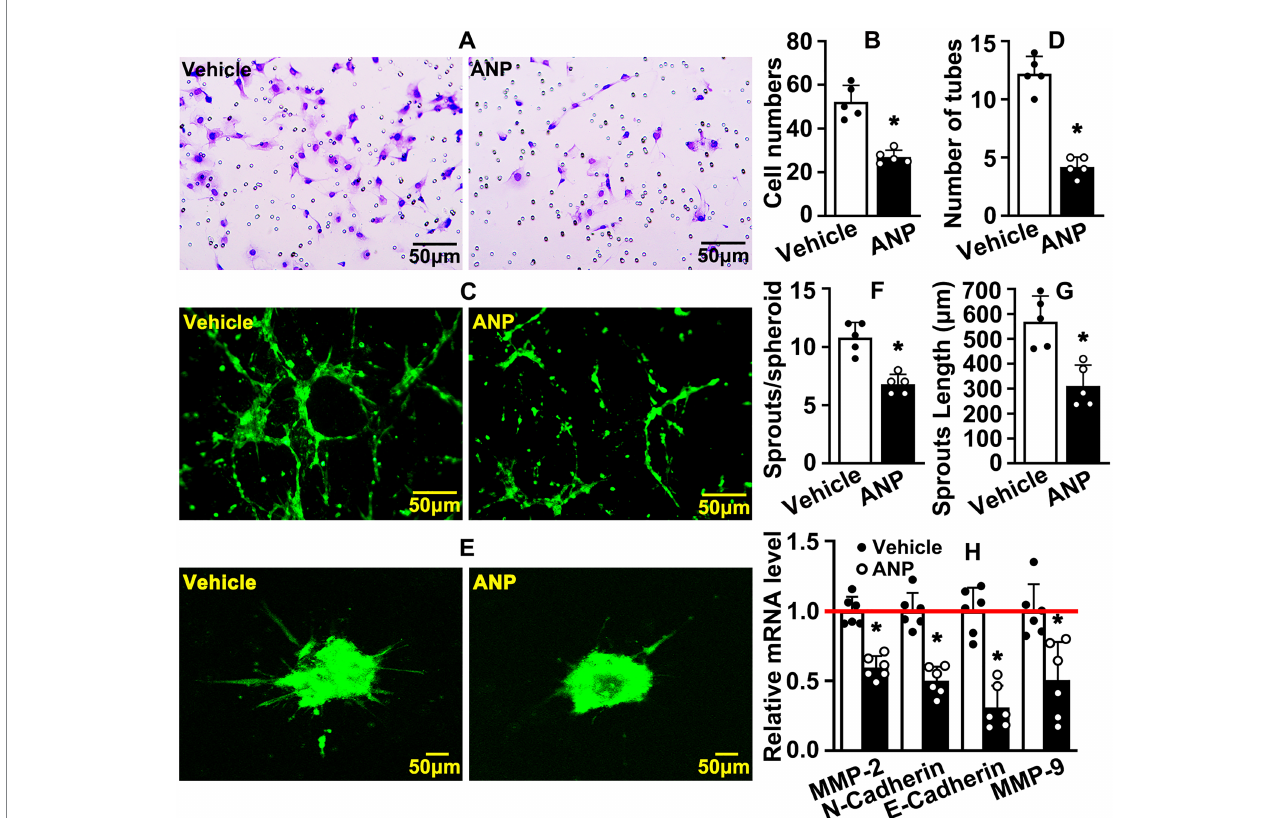
FIGURE 3 Andrographolide suppresses endothelial cell migration. (A) After 12 h of andrographolide treatment, migration of HUVEC-C was detected by Boyden chamber assay ( n = 5), and migrated cells were quantified in (B) ( n = 5). (C) Matrigel-based tube formation assay was performed following andrographolide treatment for 48 h ( n = 5). The tube numbers were quantified in (D) ( n = 5). (E) The migrating ability of HUVEC-C after andrographolide treatment for 24 h was evaluated by spheroidal sprouting assay following Calcein AM staining, and sprouting numbers and sprouting lengths were quantified in (F) and (G) ( n = 5). (H) HUVEC-C was treated with andrographolide for 30 h and Real-time PCR was performed to evaluate transcription levels of migrative-related genes ( n = 6). Quantitative data presented as mean ± SEM, * p <